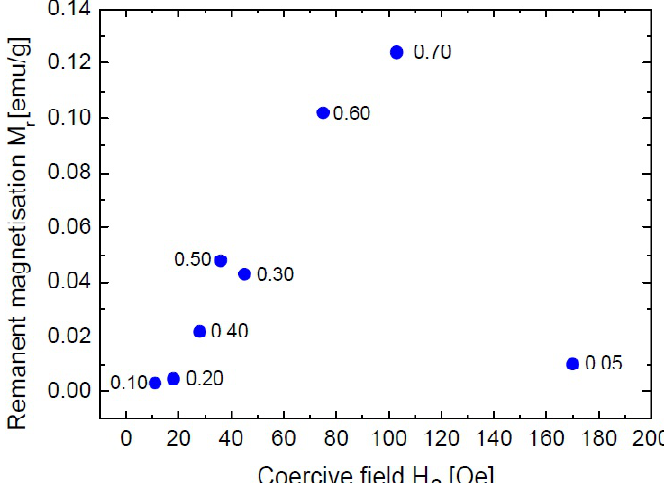
Fig. 9. Isothermal magnetisation M ( H ) (at T = 300K) for all investigated samples. The insert shows magni- fied central part of hysteresis loops.